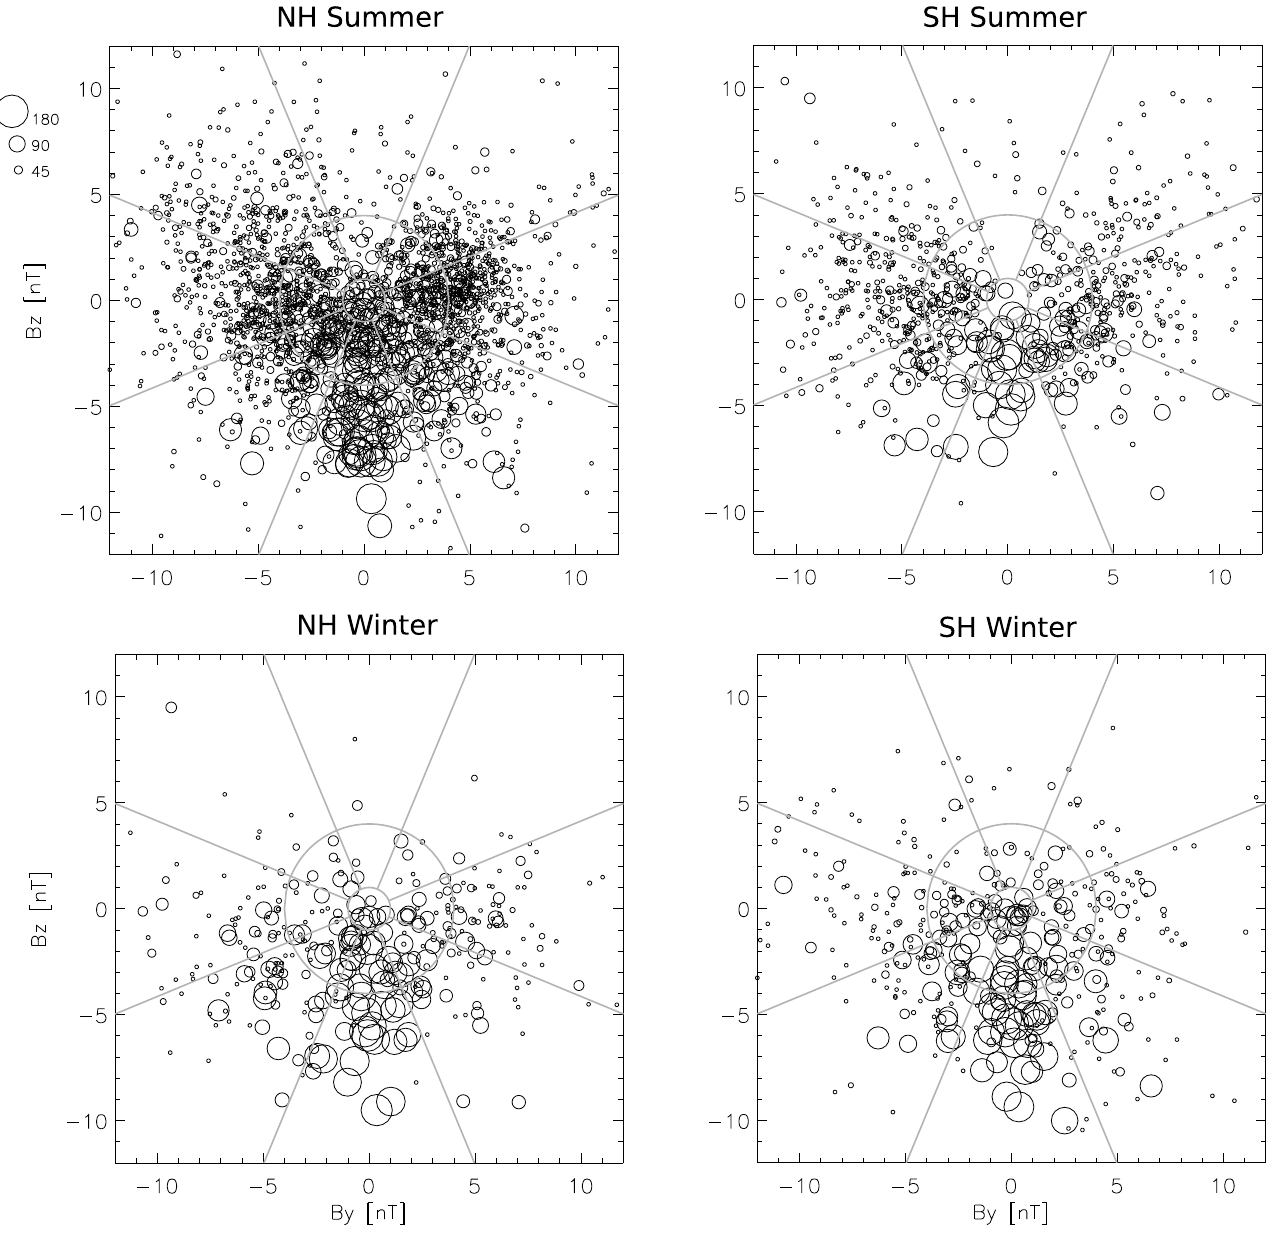
Fig. 2. IMF clock angle and magnitude distribution of stable field-aligned current events. Each panel is divided into eight clock angles and three IMF magnitude regions; | B IMF |≤ 1, 1 < | B IMF |≤ 4 and 4 < | B IMF | . The circle sizes represent the standard deviation of IMF clock angle during the one hour period for that event. A legend showing standard circle sizes is shown at the top